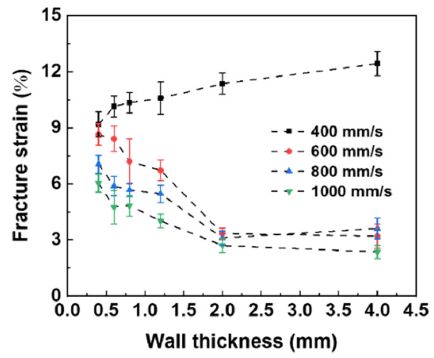
Figure 8. The evolution of fracture strain of all samples in Figure 7 with wall thickness under differ ‐ ent scanning speeds (the error bars are derived from repeated experiments under the same condi ‐ tions).